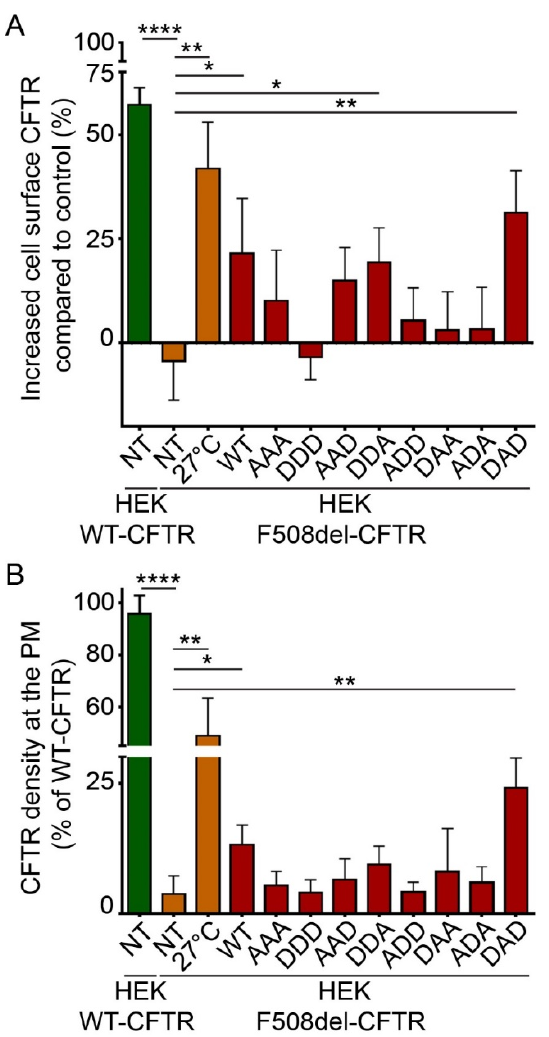
Figure 4. Phosphorylation ‐ dependent ability of HspB5 to rescue the PM localization of F508del ‐